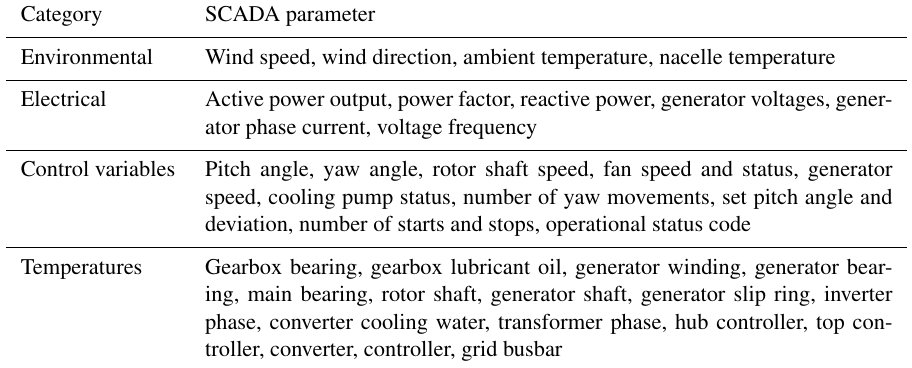
Table 1. Overview of some basic SCADA parameters (based on Tautz-Weinert and Watson, 2016; Yang et al., 2013, 2014; Godwin and Matthews, 2013; Garcia et al., 2006; Zaher et al., 2009; Catmull, 2011; Watson et al., 2011; Schlechtingen et al., 2013; Wilkinson et al., 2014; and Sun et al.,